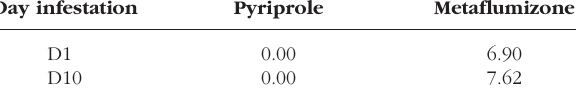
Fig. 2. – Mean number of engorges female sandflies. Groups with different super- scripts are statistically signi- ficant at p < 0.05. Groups with different superscripts are statistically significant at p <